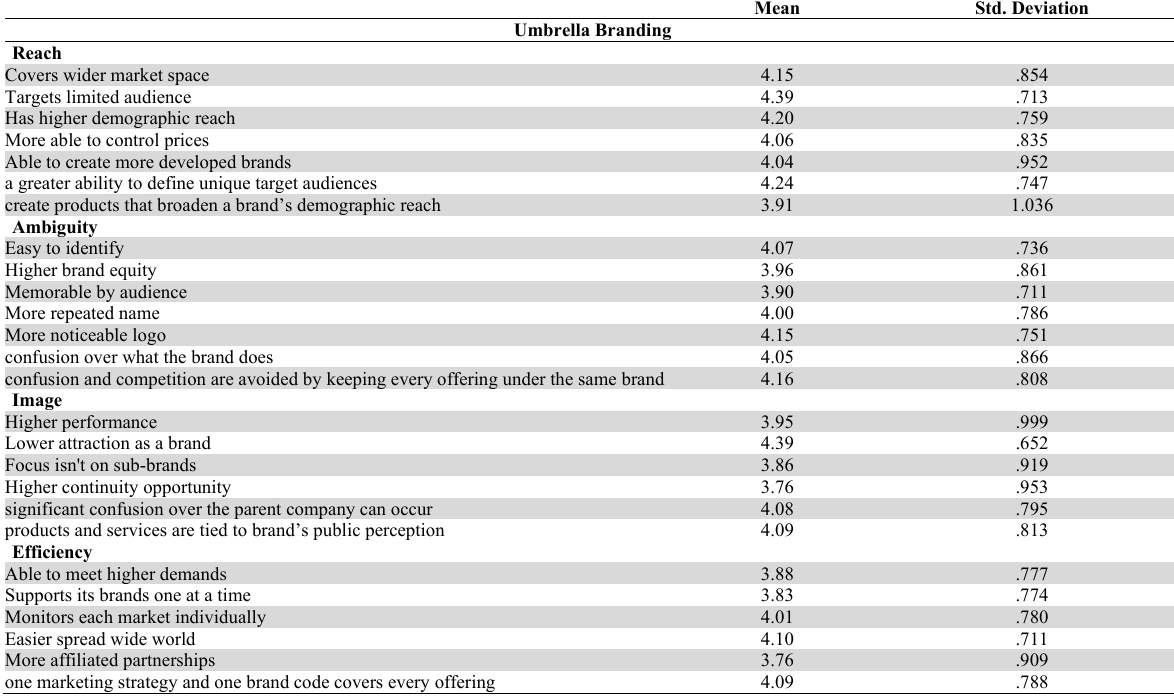
Umbrella branding